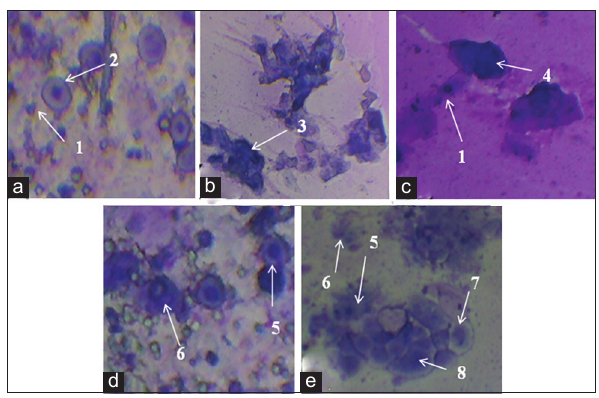
Figure-2: Cell types by vaginal smear in Cavia cobaya after giving 50 mg/head orally. (a) Proestrus: (1) Erythrocyte and nucleated superficial cells (2); (b) proestrus-estrus: (3) Enucleated superficial cells; (c) estrus: (1) Erythrocyte and (4) the superficial cells pyknotic nucleus; (d) metestrus: (5) Parabasal cells and (6) neutrophils; (e) diestrus: (5) Parabasal cells, (6) neutrophils, (7) small and medium cells, (8) major intermediate